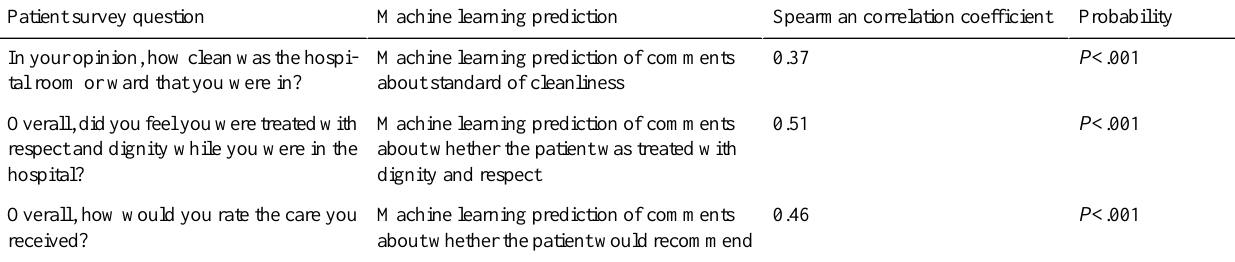
Table 3. Comparison of patient survey responses and machine learning prediction of comments at hospital trust